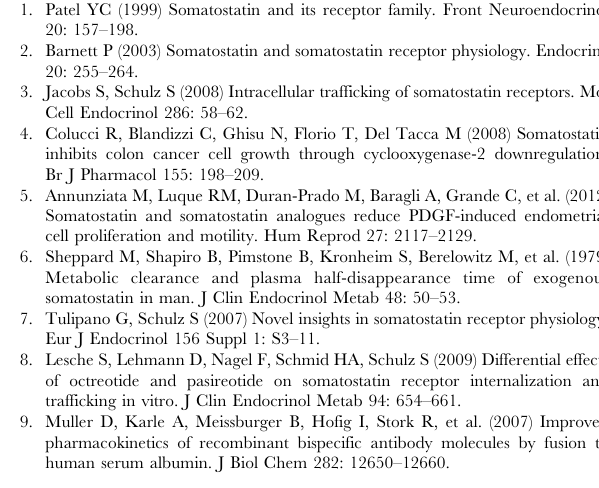
Table S1 Primer sequences used in the identification of HEK 293 cells stably expressing human